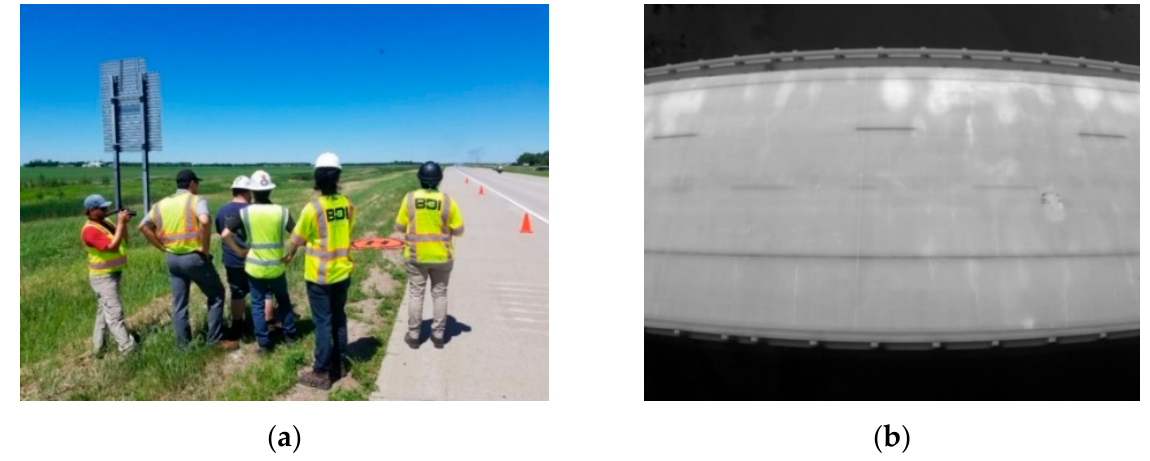
Figure 2. IRT data collection depicting ( a ) crew collecting data with a UAS and ( b ) sample of IRT image. Table 3. Ambient weather condition and inspection dates for IRT data collection.